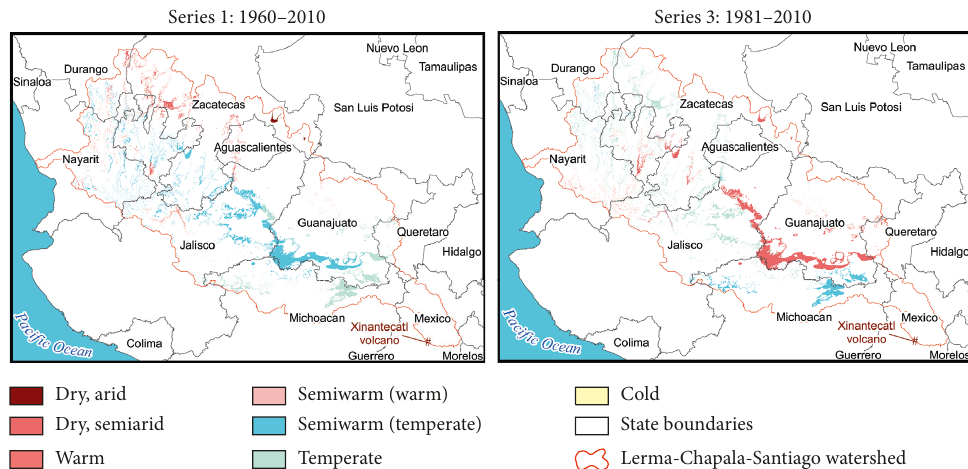
Figure 6: Areas of the watershed with changes in temperature conditions between time series one (1960–2010) and time series three